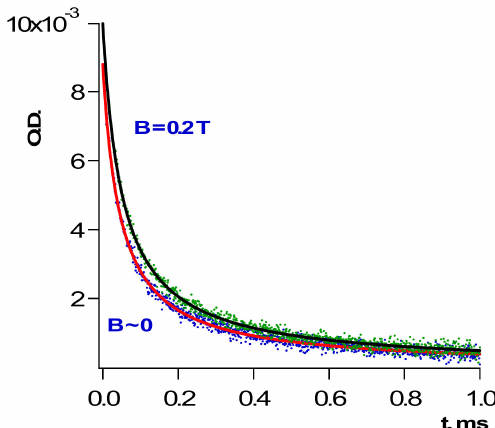
Figure 4. Kinetic traces of BH • decay measured at λ 545 nm. They correspond to the second-order reaction (7) in E proceeding in the external MF and in the Earth’s MF. Solid lines present computer simulation of experimental data (dots) into the second-order kinetics. Adapted from Ref. [24]; see this Ref. for